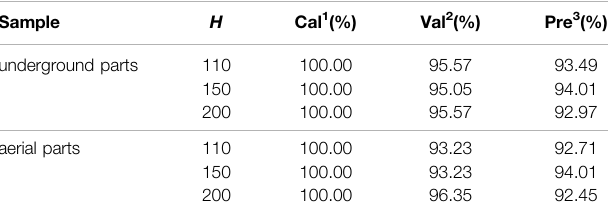
TABLE2| Theresultsof2D-CNNwiththeinputofspectralmatrixforunderground and aerial parts of G. rigescens Franch.